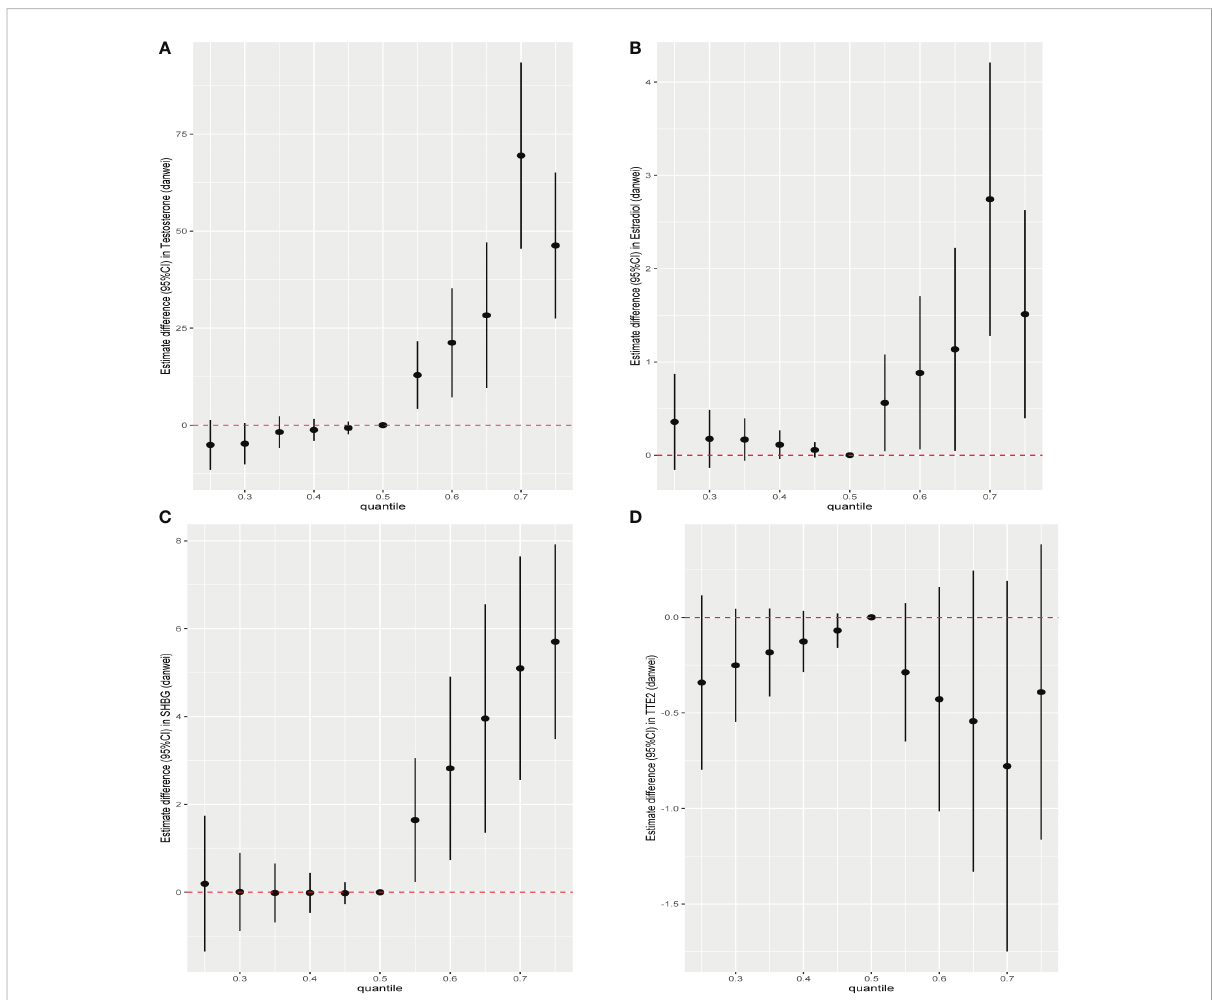
FIGURE 6 The overall effect of the eight speci fi c blood VOCs exposure on (A) male testosterone, (B) male estradiol, (C) male SHBG and (D) TT/E2 using the BKMR model. The vertical ordinate showed the estimated change in sex hormones in relation to the eight speci fi c blood VOCs at a particular percentile (labelled at the X-axis) compared to corresponding